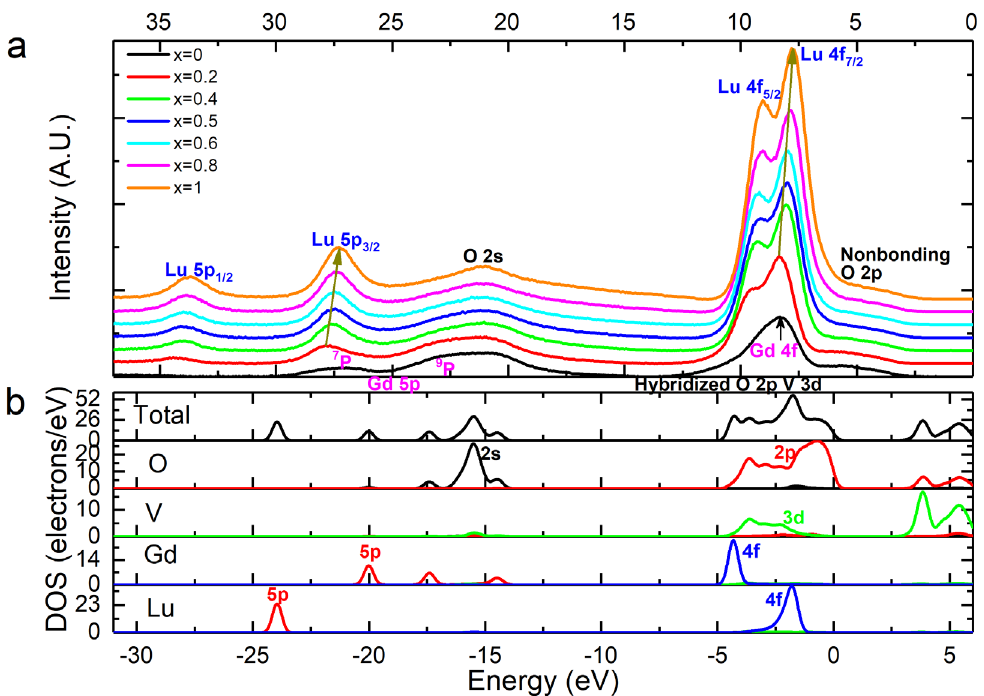
Figure 11. ( a ) Background-subtracted XPS valence band spectra of Lu x Gd 1 − x VO 4 ( 0 ≤ x ≤1) solid solutions; ( b ) LSDA + U -calculated DOS and PDOS of Lu 0.5 Gd 0.5 VO 4 .